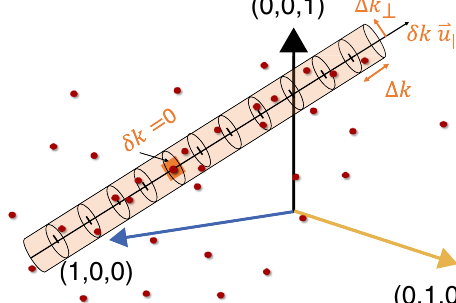
FIG. 6. Method to calculate G ð 2 Þ . One atom from a given shot is chosen (highlighted in orange). A tube of radius Δ k ⊥ oriented along ⃗ u and centered on the considered atom is defined. The distances δ k between the atom and the other ones contained in the tube are extracted. The operation is repeated for all the atoms of the shot, and the results are saved in a histogram with a longitudinal step Δ k